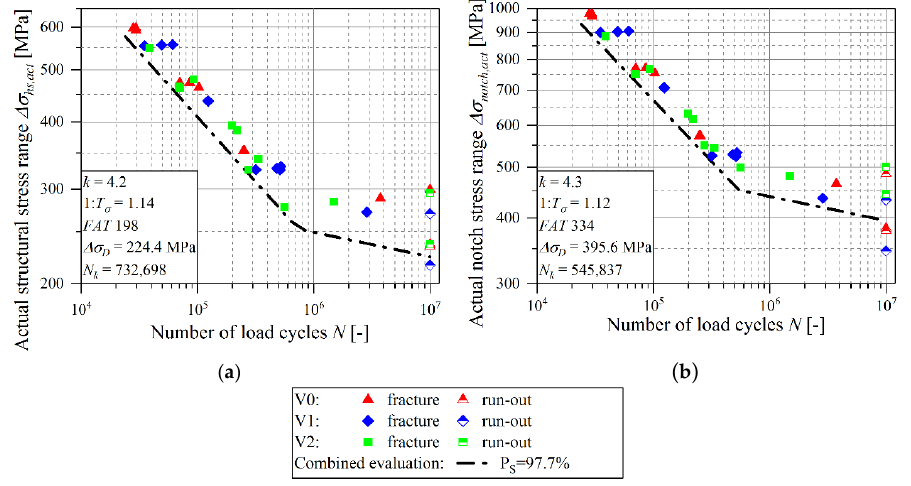
Figure 21. Resulting S/N-curves with consideration of specimen distortion. ( a ) Actual structural stress including consideration of effective stress ratio; ( b ) Actual notch stress including consideration of effective stress ratio.